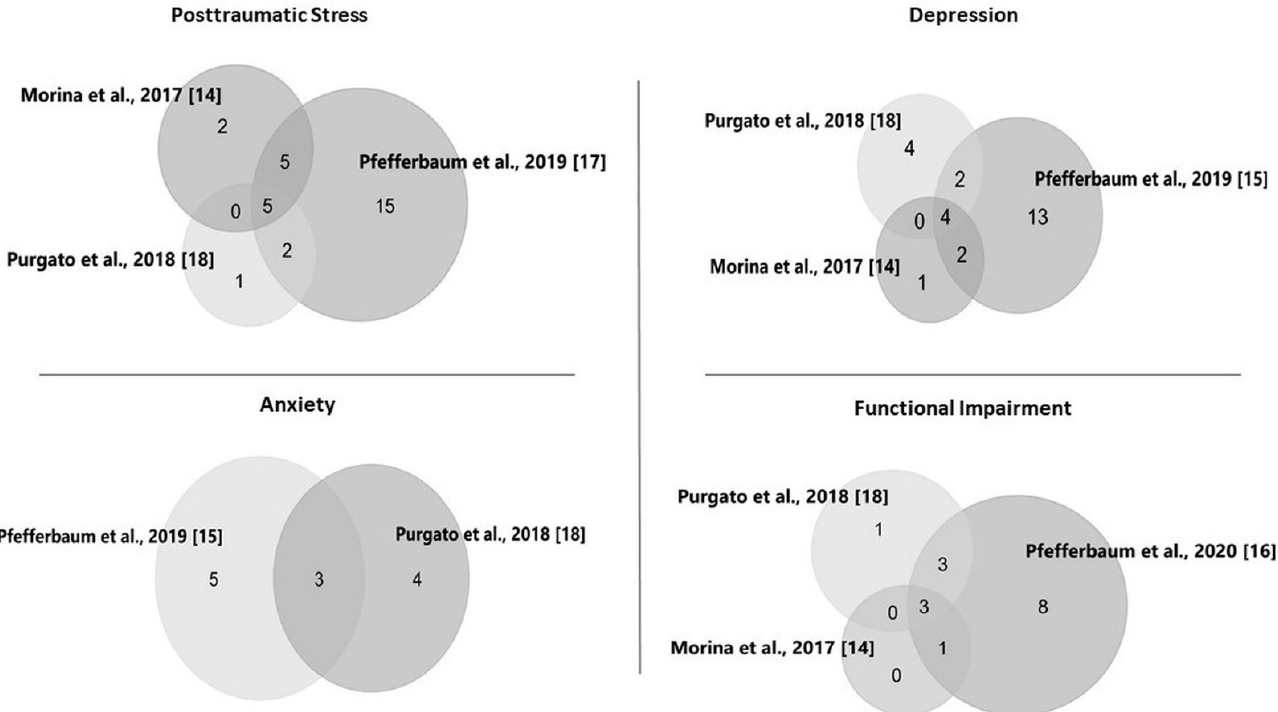
Figure 1. Overlap of trials across the meta-analyses. Note: The numbers in the figures are the numbers of trials that overlap or do not overlap across the meta-analyses. Of the 5 studies included in the meta-analysis of the intervention effect on posttraumatic stress by Tol and colleagues [19], 3 were also included in Morina and colleagues [14], 2 in Purgato and colleagues [18], and 3 in Pfefferbaum and colleagues [17].